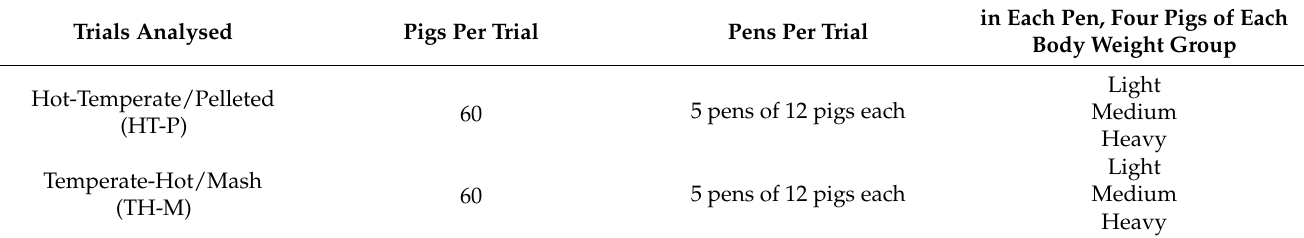
Table 1. Schema of the pigs used in each